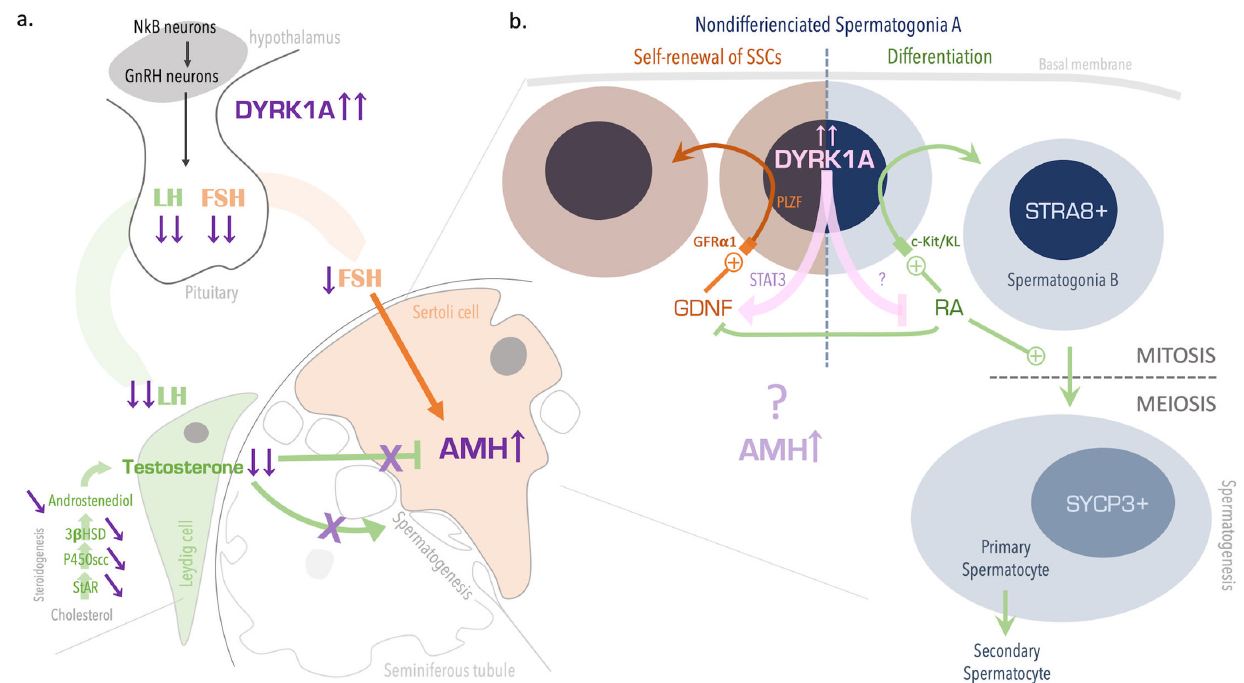
Figure 4. Mechanisms of impaired fertility in Tg mice overexpressing DYRK1A. Hypogonadotropic hypogonadism ( a ) might be induced by central overexpression of DYRK1A in the hypothalamus and/or the pituitary; the overexpression might be responsible for lowering the production of LH and FSH gonadotrophins. In the testis, low LH levels slow down steroidogenesis and reduce testosterone levels, which in turn reduced spermatogenesis stimulation and upregulation of AMH levels in Sertoli cells. In germ cells ( b ), overexpression of DYRK1A in the early stages of spermatogenesis prompts spermatogonia to self-renew rather than to differentiate and enter meiosis. This process might be mediated by activation of STAT3 and GDNF, downregulation of retinoic acid (RA), and perturbation of the mitosis-to-meiosis transition by excess AMH.